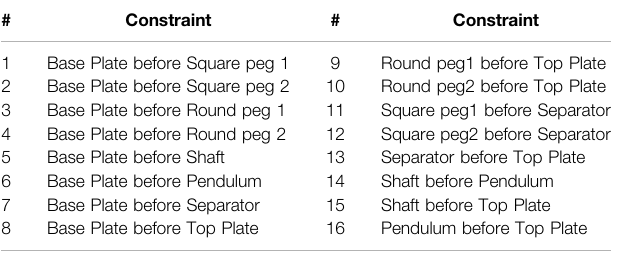
TABLE1| ThelistofrequiredconstraintsforassemblingtheCran fi eldbenchmark.